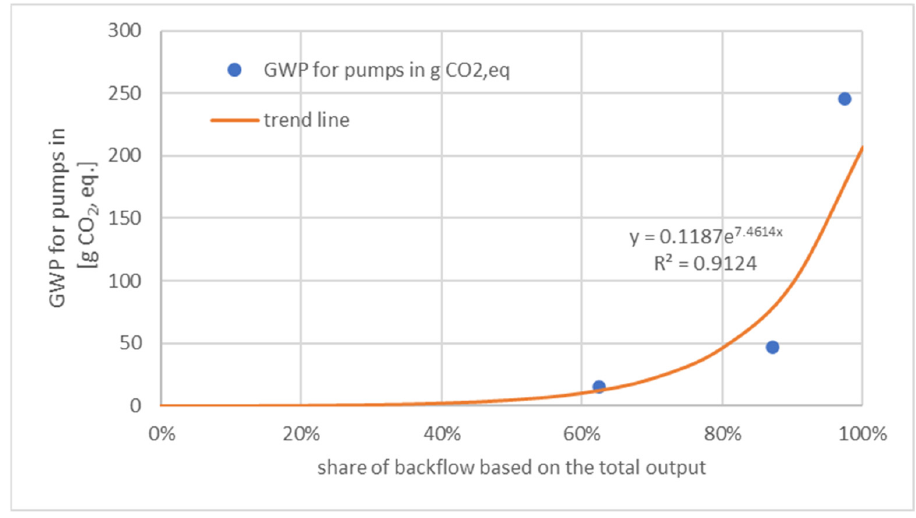
Figure 18. Relationship between backflow and GWP from compressor usage (Source: Energieinstitut an der JKU).